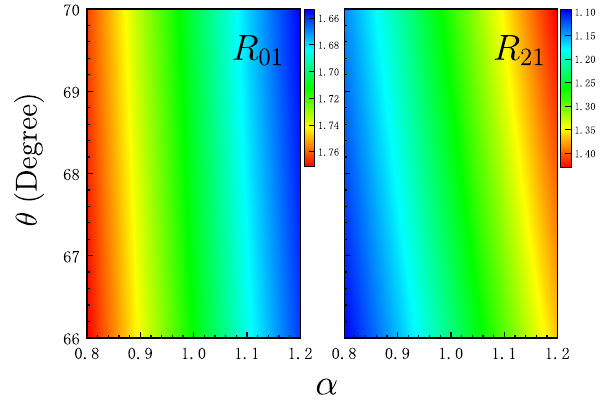
Fig. 7 The ratios R 01 = (cid:5) [ X → π 0 χ c 0 ] /(cid:5) [ X → π 0 χ c 1 ] (left panel) and R 21 = (cid:5) [ X → π 0 χ c 2 ] /(cid:5) [ X → π 0 χ c 1 ] (right panel) depending on the parameter α and